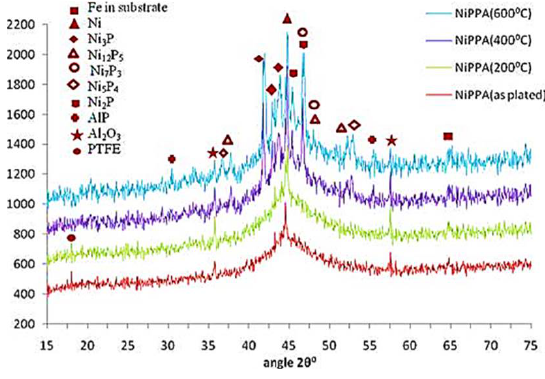
Figure 2. XRD analysis of NiPPA nano-dispersion coating of as plated and heat treated at 200 ◦ C, 400 ◦ C and 600 ◦